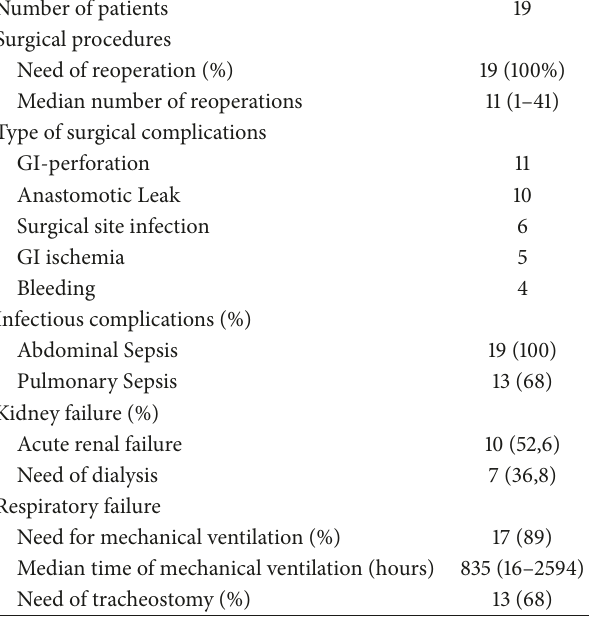
Table 1: Patient demographics, cardinal diagnosis, type of hospital and ICU admission, and indication for ICU admission.